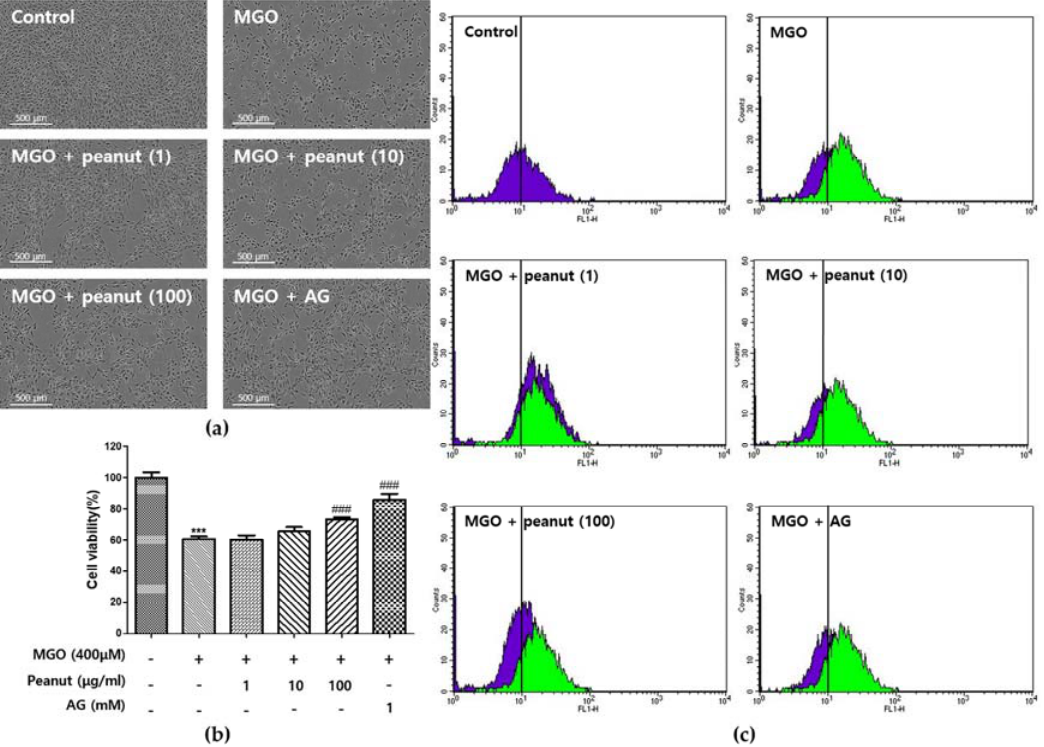
Figure 2. The effects of peanut extracts on methylglyoxal (MGO)-induced cytotoxicity in human umbilical vein endothelial cells (HUVECs). ( a ) Representative photographs of MGO-treated HUVECs without ( − ) or with (+) peanut extracts. ( b ) The viability of HUVECs treated with MGO and peanut extract. Cell viability was analyzed using the MTT assay. The percentage of cell viability is presented as the mean ± SD of three independent experiments. ( c ) The protective effect of peanut extract on MGO-induced ROS generation. HUVECs were pretreated with peanut extract for 1 h and then treated with 400 µ M MGO for 2 h. ROS generation was detected by staining with the fluorescent dye DCF-DA. MGO: 400 µ M methylglyoxal; MGO + peanut (1): MGO + 1 µ g/mL peanut extract; MGO + peanut (10): MGO + 10 µ g/mL peanut extract; MGO + peanut (100): MGO + 100 µ g/mL peanut extract; MGO + AG: MGO + 1 mM aminoguanidine. (*** p < 0.001 vs. control; ### p < 0.001 vs. MGO treatment only).